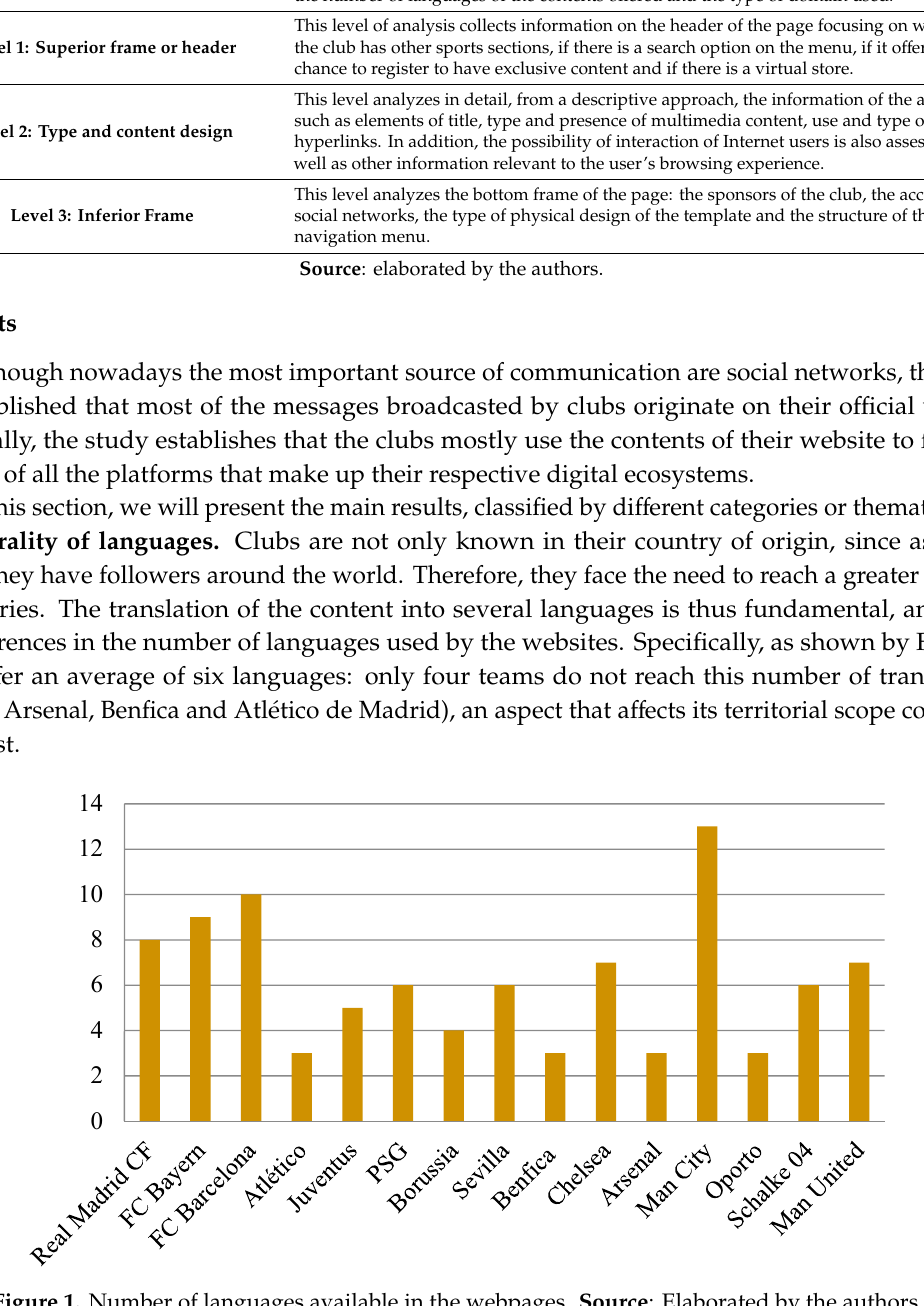
Table 4. Distribution of the header.